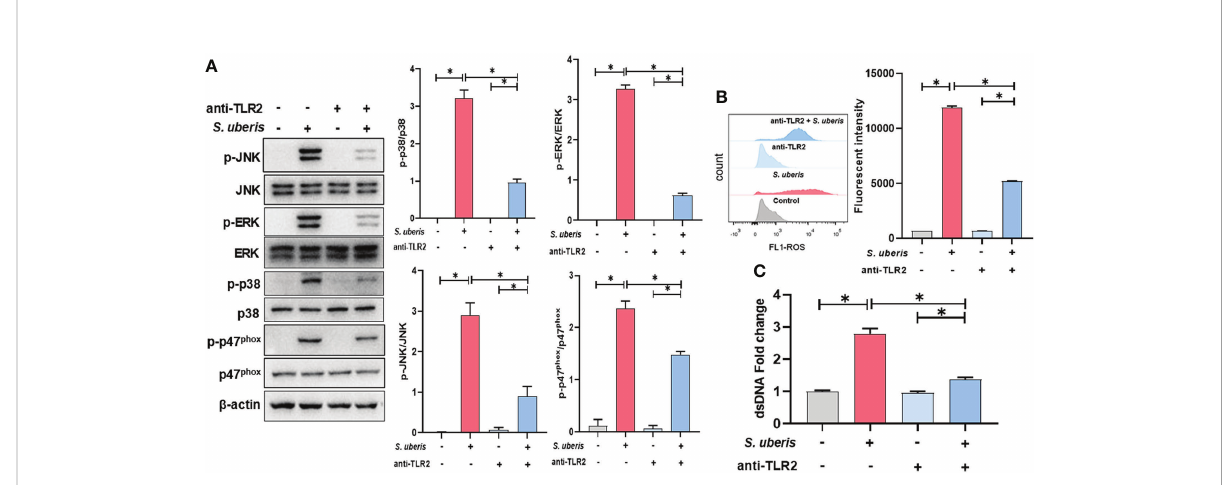
FIGURE 4 TLR2 mediates the activation of MAPK signaling pathways in S. uberis infection. The neutrophils were pretreated with TLR2-antibody (anti-TLR2, 100 ng/mL) for 1 h before infected with S. uberis at MOI of 10. (A) Immunoblot and statistical analysis of neutrophil p38, ERK, JNK and p47 phox proteins and phosphorylated proteins at 2 h. (B) The Intracellular ROS level evaluated by Flow Cytometry at 2 h. (C) The dsDNA content in supernatant at 4 h. Data are presented as mean ± SEM (n = 3). * P <